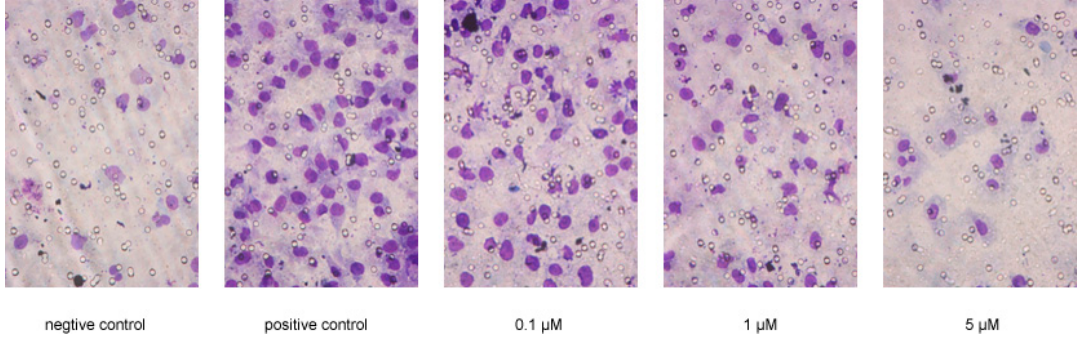
Figure 4. Anti-invasive effect of compound 1 on MDA-MB-231 cells by chemotaxis assay.